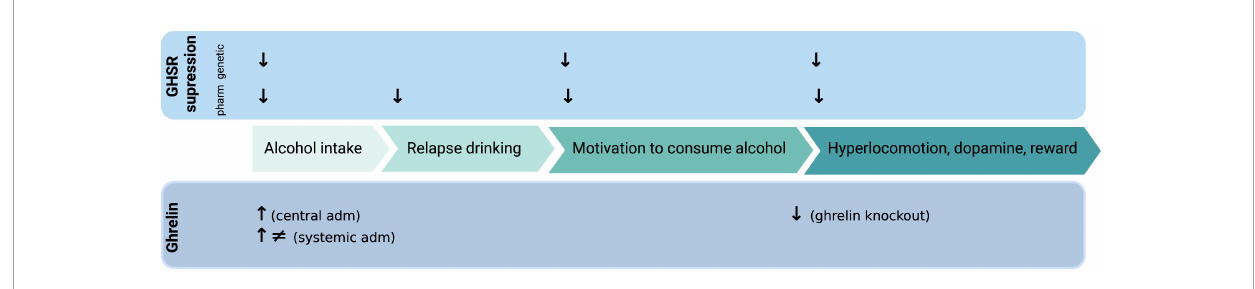
FIGURE1 Illustrative summary of available preclinical studies on how ghrelin administration (adm) or genetic/pharmacologic (pharm) GHSR (growth hormone receptor, ghrelin receptor) suppression influences various alcohol-related responses. ↓ , decreases; ↑ , increases; (cid:54)= , no effect. Created with